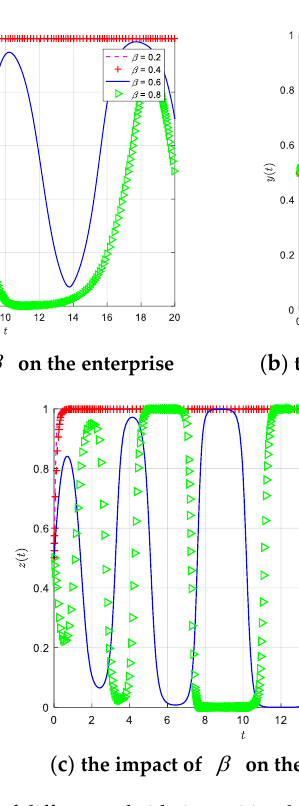
Figure 7. The impact of different subsidy intensities β on the enterprise, service provider, and government.